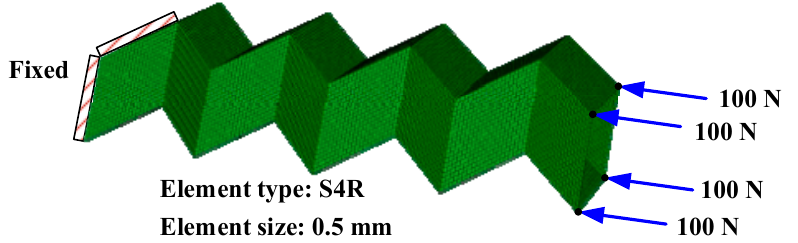
Table 1. The material properties of the CFRP origami metamaterial.